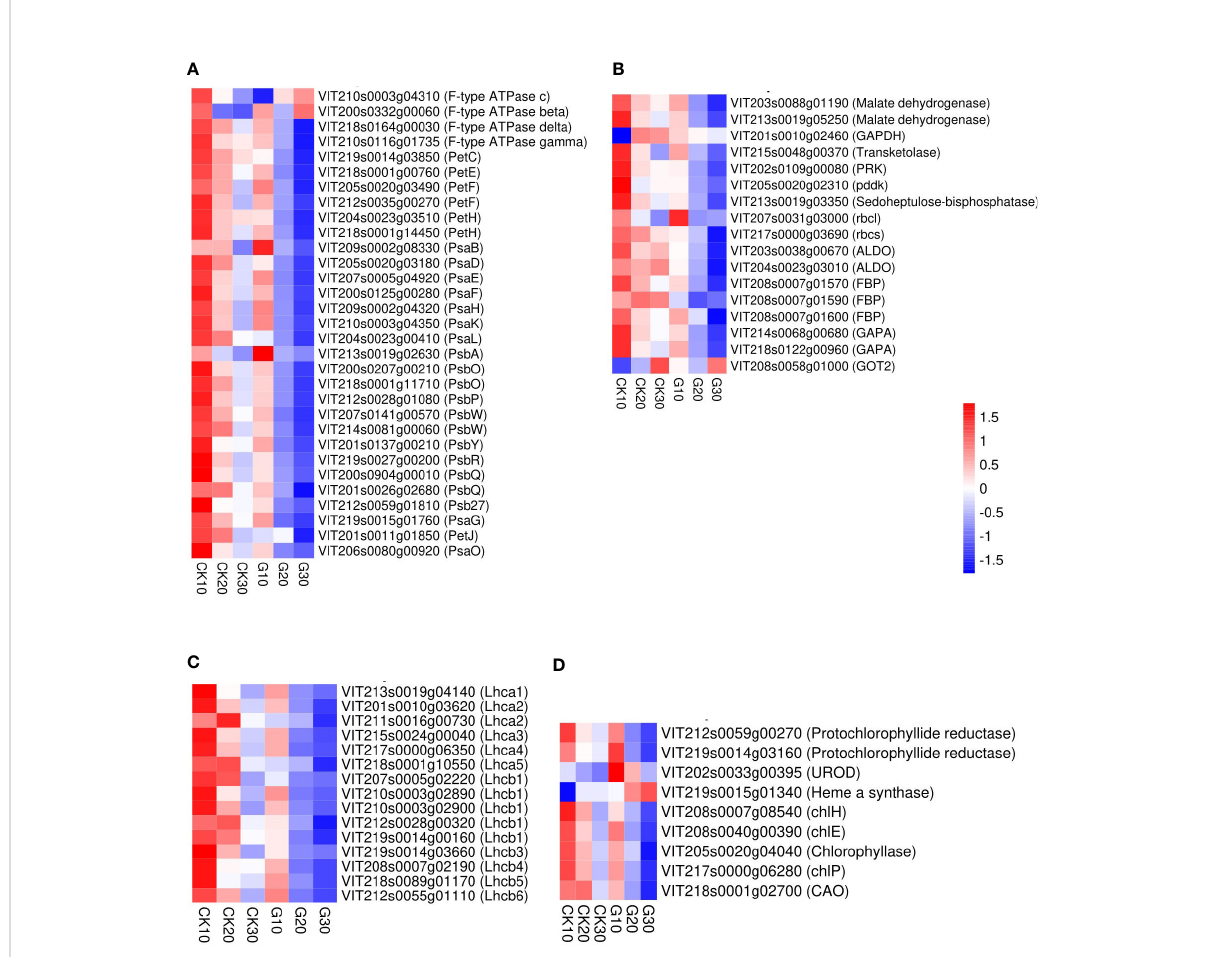
FIGURE 6 Heatmaps of DEGs related to photosynthesis of grape berries. (A) DEGs in the photosynthesis pathway. Pet, photosynthetic electron transport; Psa, photosystem I subunit; Psb, photosystem II subunit; DEGs, differentially expressed genes. (B) DEGs in the photosynthesis-antenna proteins pathway. ALDO, fructose-bisphosphate aldolase; FBP, fructose-1,6-bisphosphatase; GAPA, glyceraldehyde-3-phosphate dehydrogenase; GOT2, aspartate aminotransferase; pddk, pyruvic-phosphate dikinase; PRK, phosphoribulokinase; rbcl, ribulose-bisphosphate carboxylase large chain; rbcs, ribulose-bisphosphate carboxylase small chain. (C) DEGs in the carbon fi xation in photosynthetic organisms pathway. Lhca, light- harvesting complex I chlorophyll a/b binding protein; Lhcb, light-harvesting complex II chlorophyll a/b binding protein. (D) DEGs in the porphyrin and chlorophyll metabolism pathway. CAO, chlorophyllide a oxygenase chlE, magnesium-protoporphyrin IX monomethyl ester (oxidative) cyclase; chlH, magnesium chelatase subunit H; chlP, geranylgeranyl diphosphate/geranylgeranyl-bacteriochlorophyllide a reductase; UROD, uroporphyrinogen decarboxylase. TPMs of genes were used in the analysis after row z-score scaling. DEGs were labeled by gene ID (description). A color scale is shown in all four